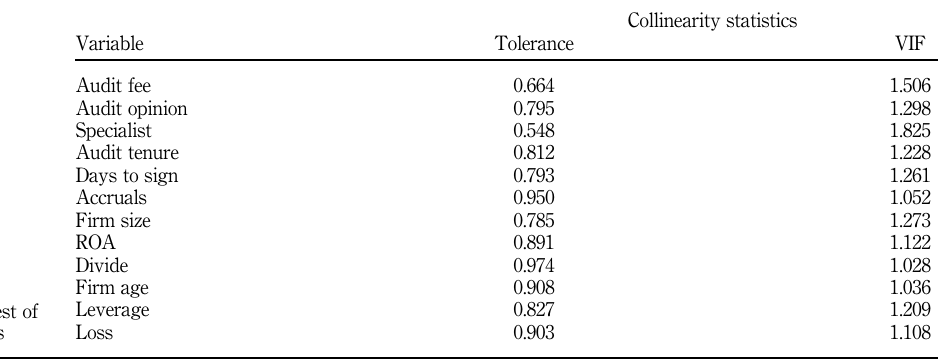
Table V. The linearity test of model